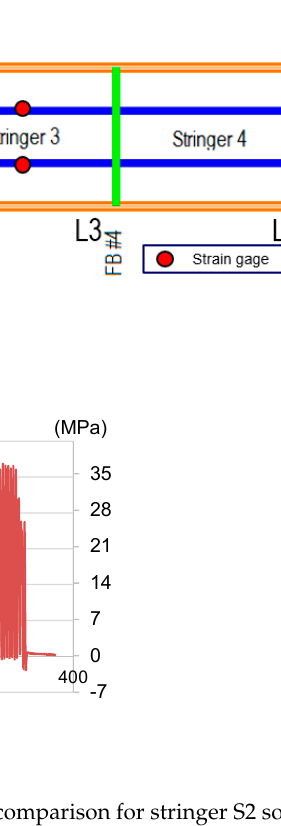
Figure 15. Stress calculated from measured strains, comparison for stringer S2 southeast.